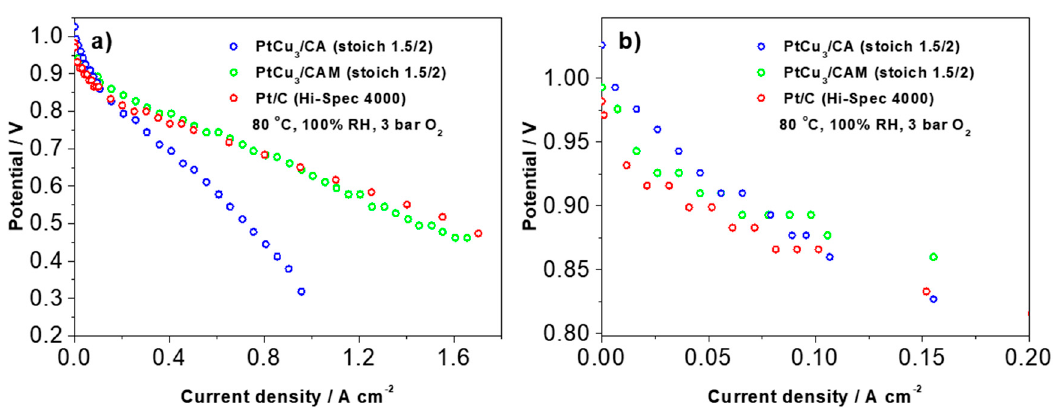
Figure 3. ( a ) XPS survey spectra of the PtCu catalyst sample before and after 30 min sputtering with 5 kV Ar + ions, ( b , c ) high-resolution XPS survey spectra of the Pt4f and Cu2p regions of the raw PtCu catalyst, and ( d ) high-resolution XPS survey spectra of the N1s region for the raw PtCu catalyst.